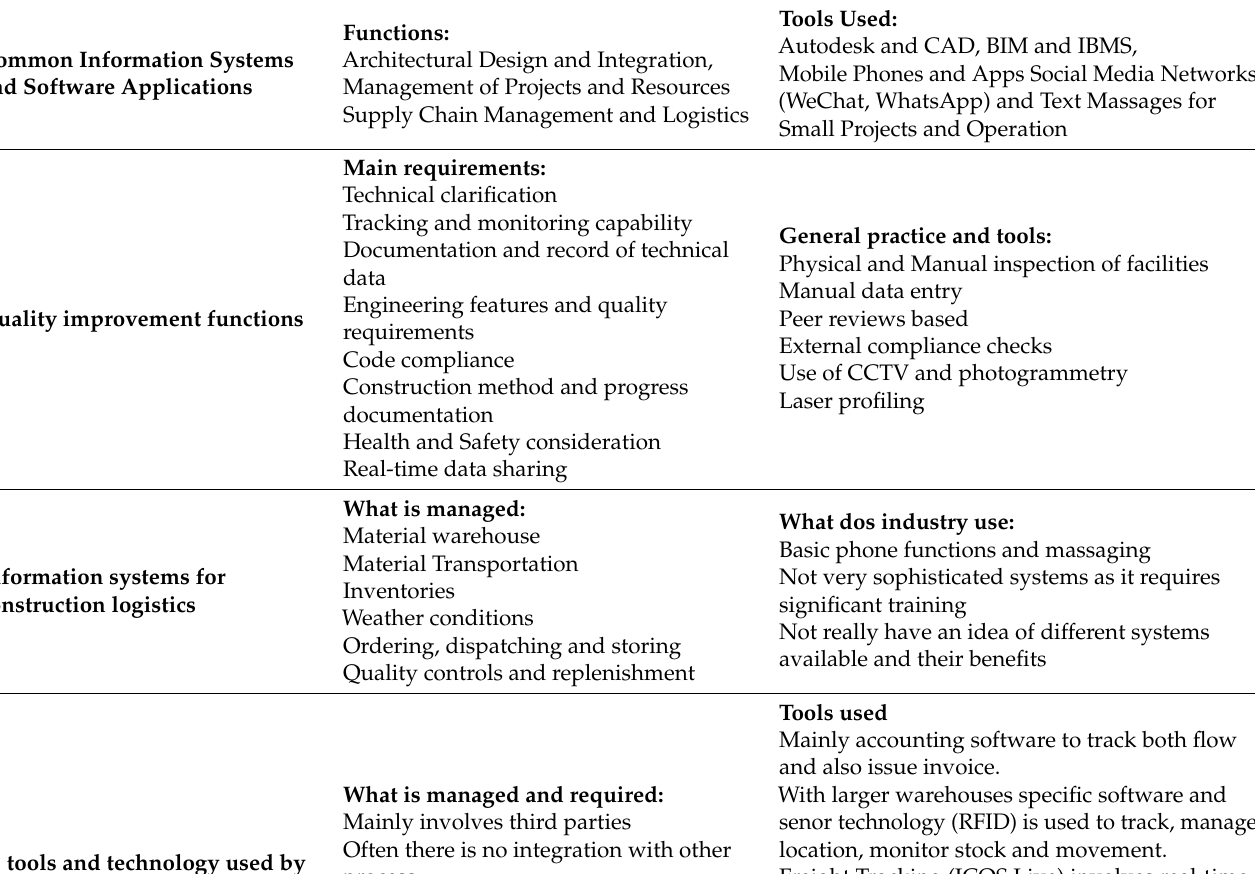
Table 3. Knowledge map of the information obtained from